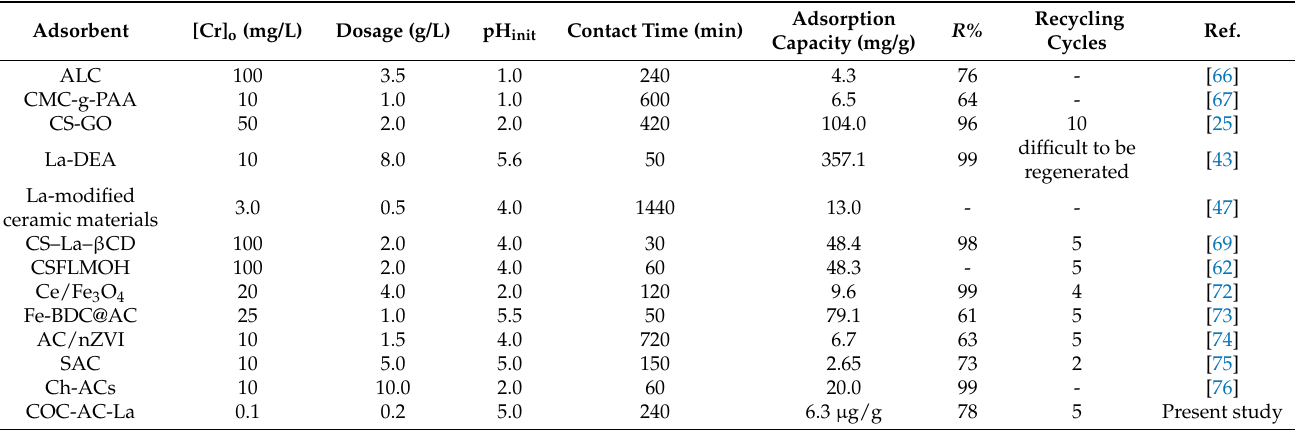
Table 6. Comparison of adsorption capacities and experimental conditions for Cr(VI) removal of current work with relevant literature